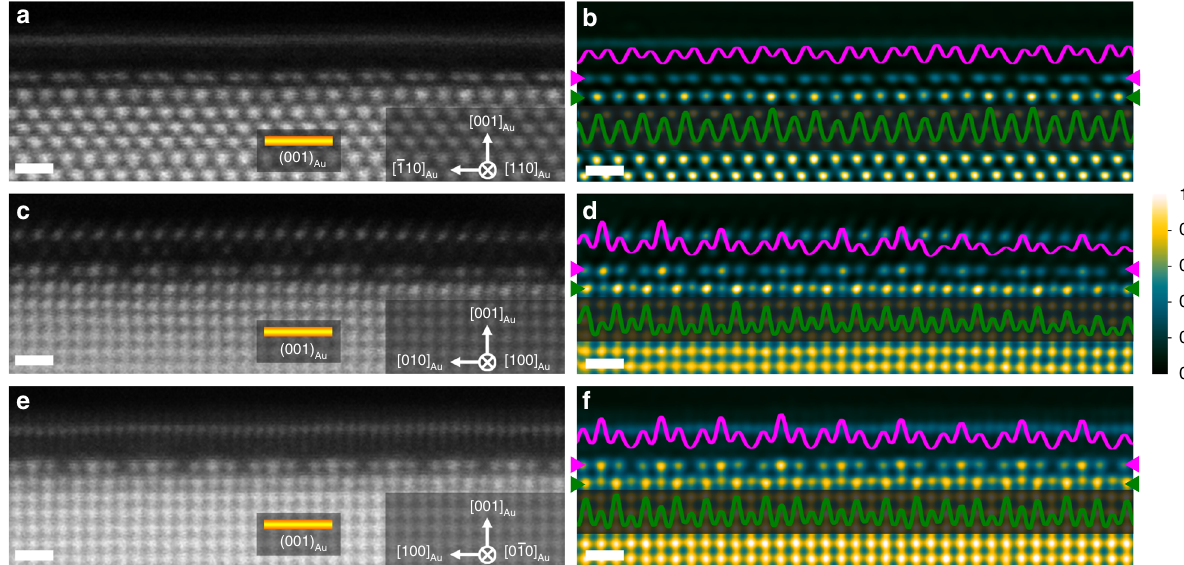
Fig. 3 Structural characterizations of the interfaces between MoS 2 monolayer and Au (001) surface of NPG. a , c , e Raw HAADF-STEM images viewed from the [110] Au ( a ), [100] Au ( c ) and [0 (cid:1) 10] Au ( e ) directions. Scale bar, 0.5 nm. b , d , f Filtered atomic-resolution HAADF-STEM images with false color viewed from the [110] Au ( b ), [100] Au ( c ) and [0 (cid:1) 10] Au ( e ) directions. Color variation from black to blue and then to yellow corresponds to the intensity from low to high. The magenta and green lines are intensity pro fi les measured along the Au topmost layer and sublayer following the corresponding arrows in ( b , d ) and ( f ), respectively. Scale bar, 0.5